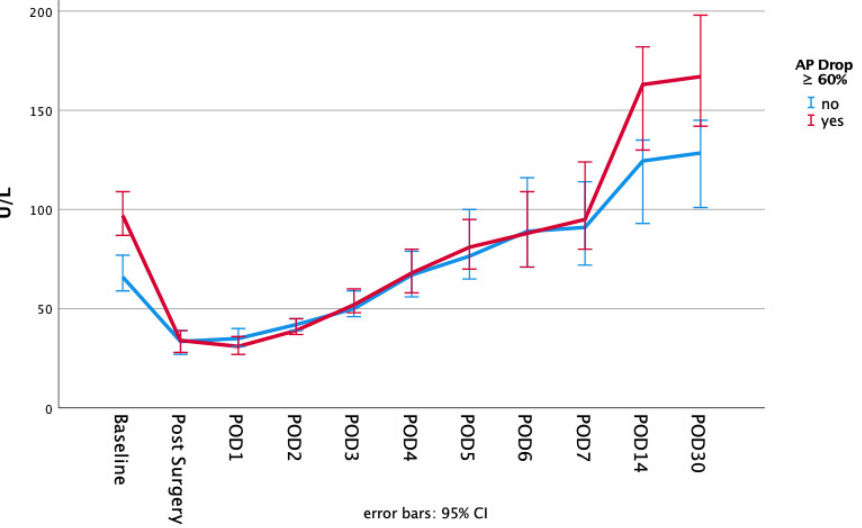
Figure 1. Alkaline phosphatase blood values dependent in the initial AP drop at the baseline on each consecutive day until POD 7, as well as on POD 14 and POD 30.